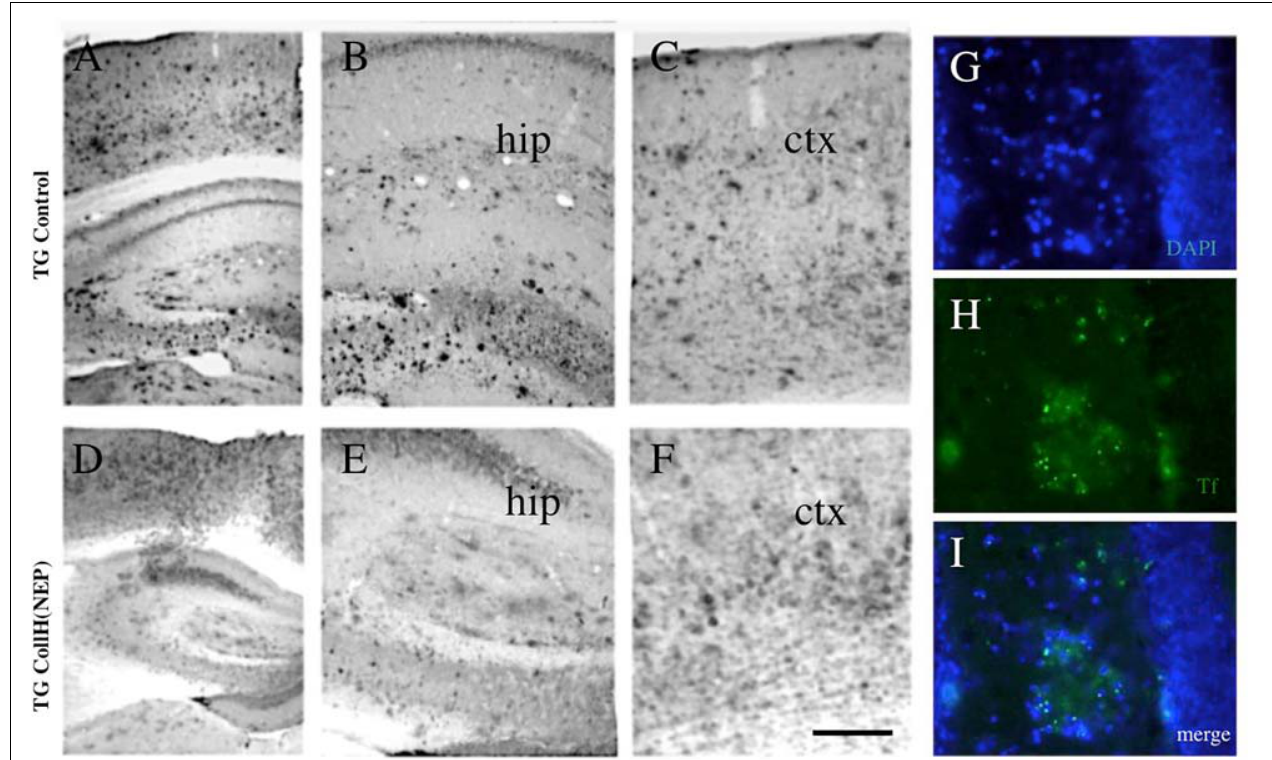
FIGURE 4 | Immunohistochemical staining of brain sections after intranasal delivery of neprilysin. Transgenic mice were intransally infused with a control [TG control; (A–C) ] or with a collagen hydrogel loaded with neprilysin [TG CollH(NEP); (D–E) ]. Brains were sectioned and stained for beta-amyloid like immunoreactivity (A–F) . Note a strong plaque load in hippocampus [hip, (B,E) ] and cortex [ctx, (C,F) ] and a somewhat reduced plaque density in mice treated with neprilysin. As an additional control plaques were stained with thioflavin S [Tf, (H,I) ] and counterstained with blue fluorescent DAPI (G,I) . Scale bar in (F) = 200 µ m (A–F) ; 120 µ m (G–I)